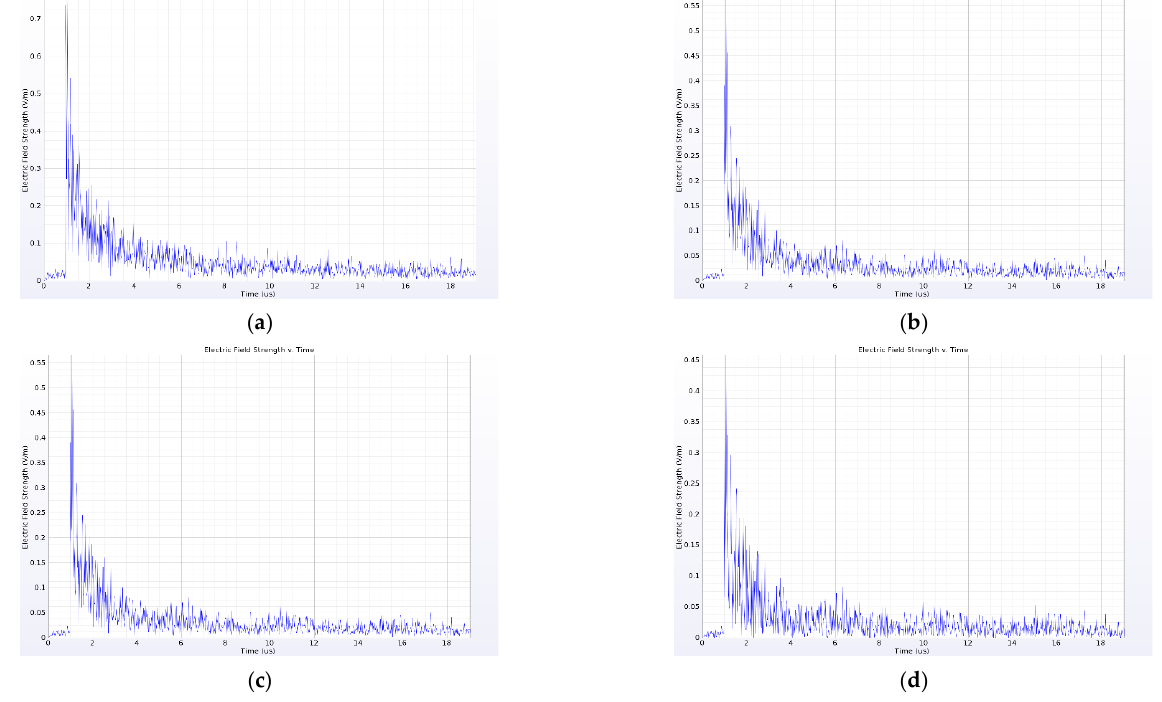
Figure 6. Effect of current transformer on near-field propagation characteristics of PD electromagnetic wave signal. ( a ) Electric field strength at point sensor 1; ( b ) Electric field strength at point sensor 2; ( c ) Electric field strength at point sensor 3; ( d ) Electric field strength at point sensor 4.